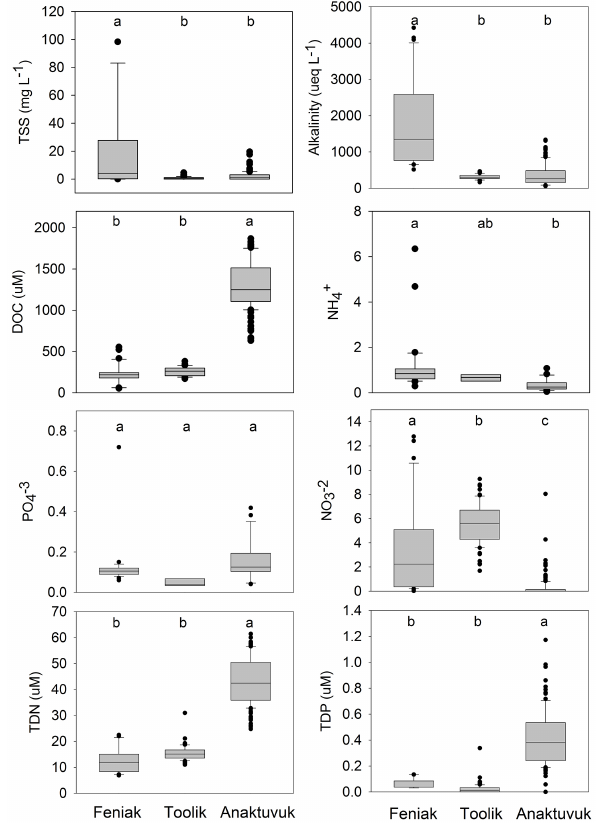
Figure 4. Biogeochemical characteristics of streams within each region (includes all available data, not just from BDOC sampling sites/dates). Box plots represent median, quartiles, minimum and maximum within 1.5 times the interquartile range, and outliers be- yond 1.5 IQR. Different letters represent significant differences be- tween regions, α = 0.05. Sample sizes vary (see